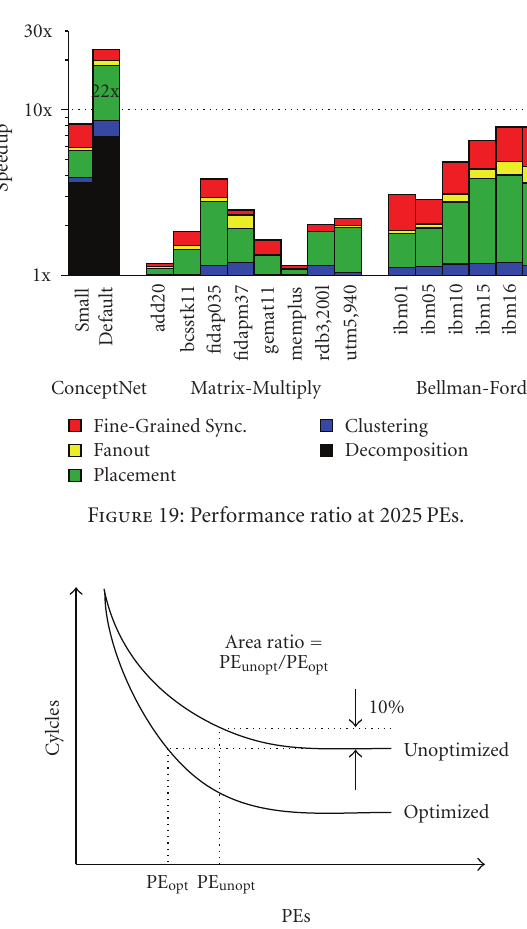
Figure 20: How we compute area